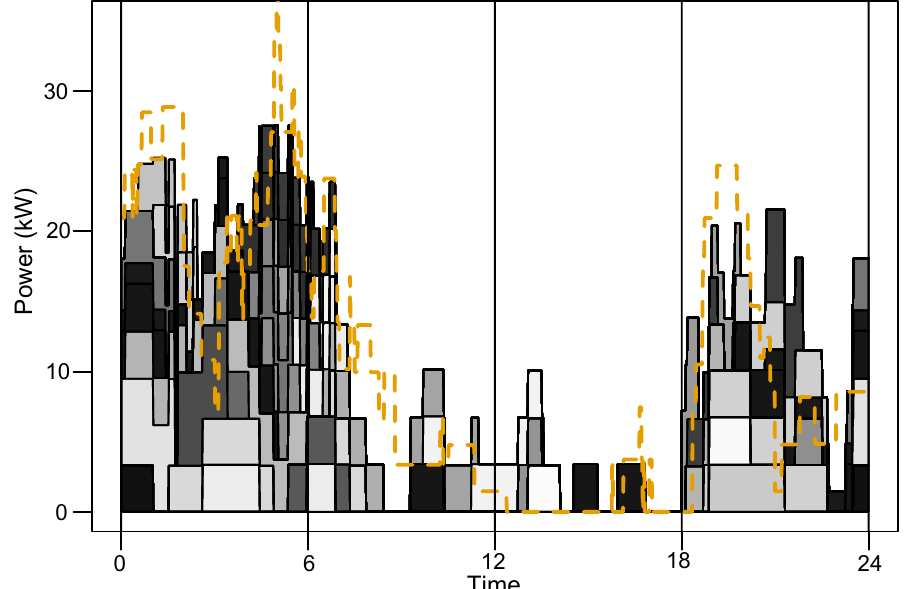
Figure 6. Day-ahead scenario forecast of a fleet of 46 EVs on Saturday 12th December 2015. The orange dashed line shows the actual consumption to be forecast. Each individual scenario is represented by a filled